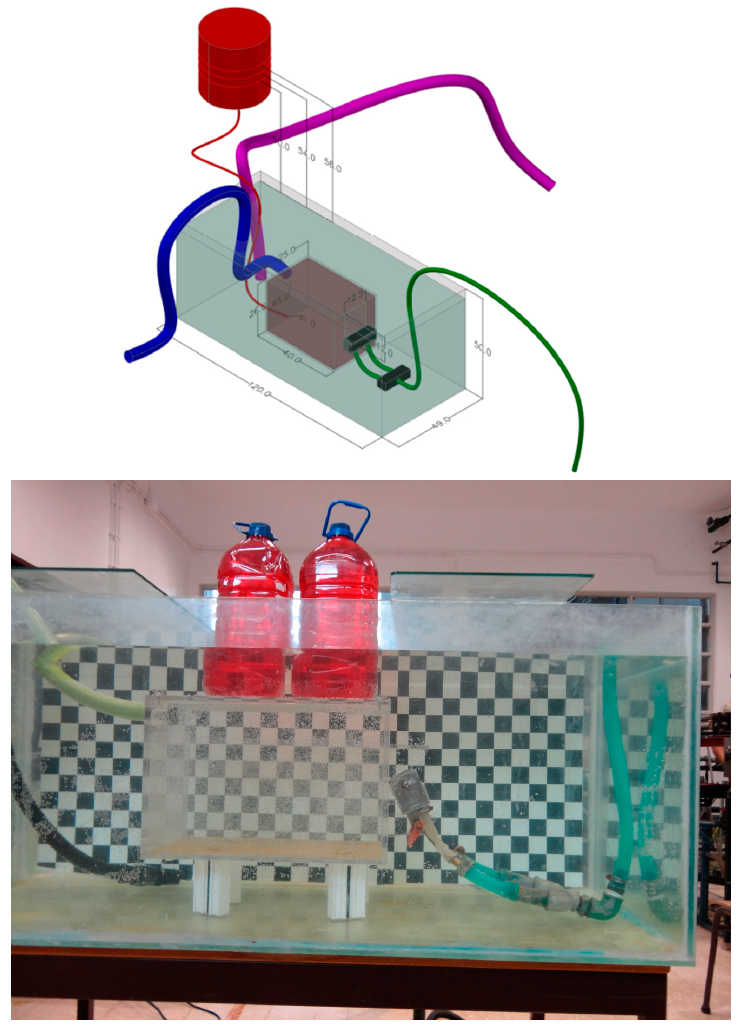
Figure 3. Test model—in the drawing, red corresponds to the contaminant circuit, dark blue to the exhaust circuit, green to the jet circuit, and purple to the water intake (dimensions in cm).